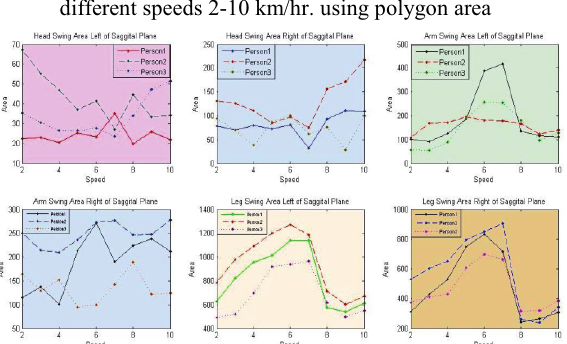
Fig. 10. Variation of features for three different persons at different speeds 2-10 km/hr. using polygon area